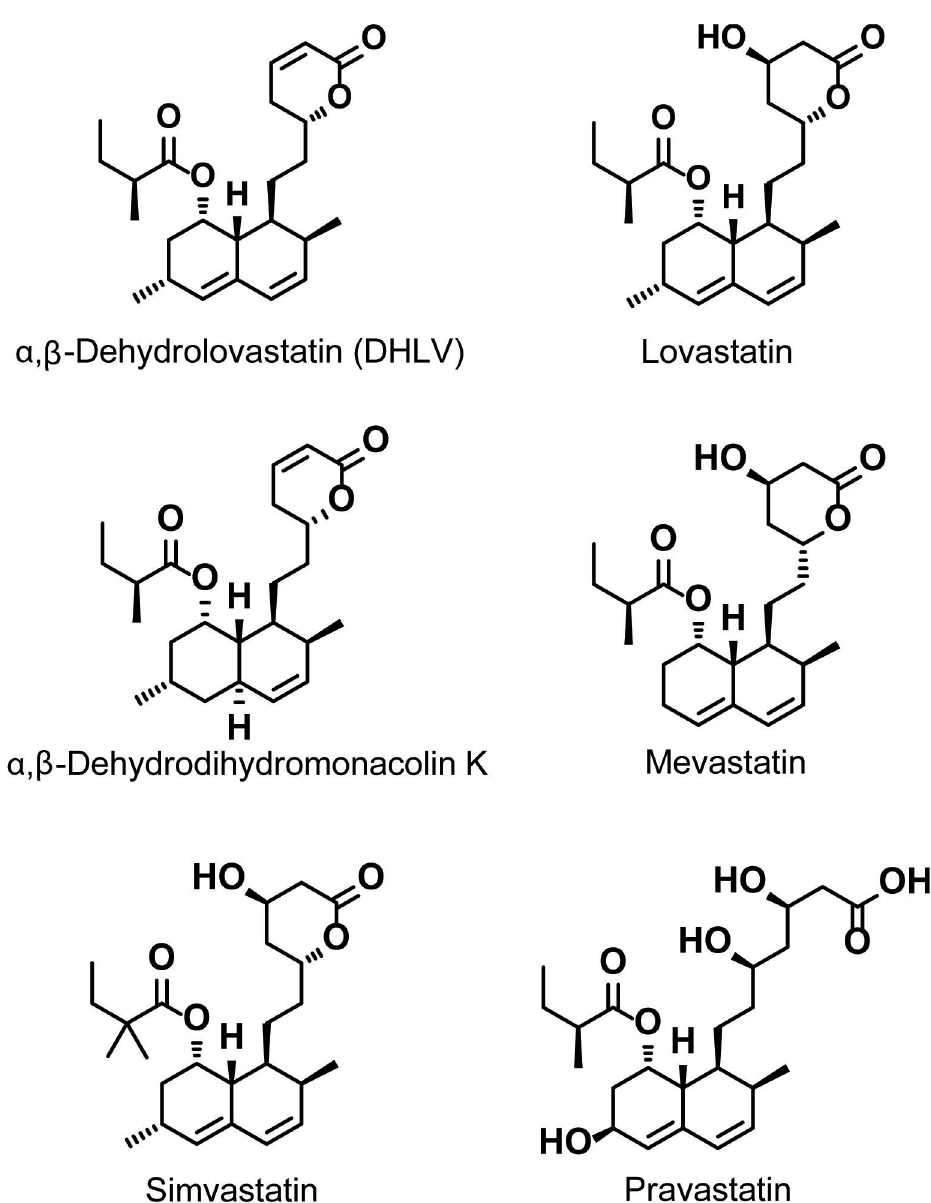
Fig 1. Chemical structures of α , β -dehydrolovastatin (DHLV), lovastatin, α , β -dehydrodihydromonacolin K, mevastatin, simvastatin, and pravastatin.